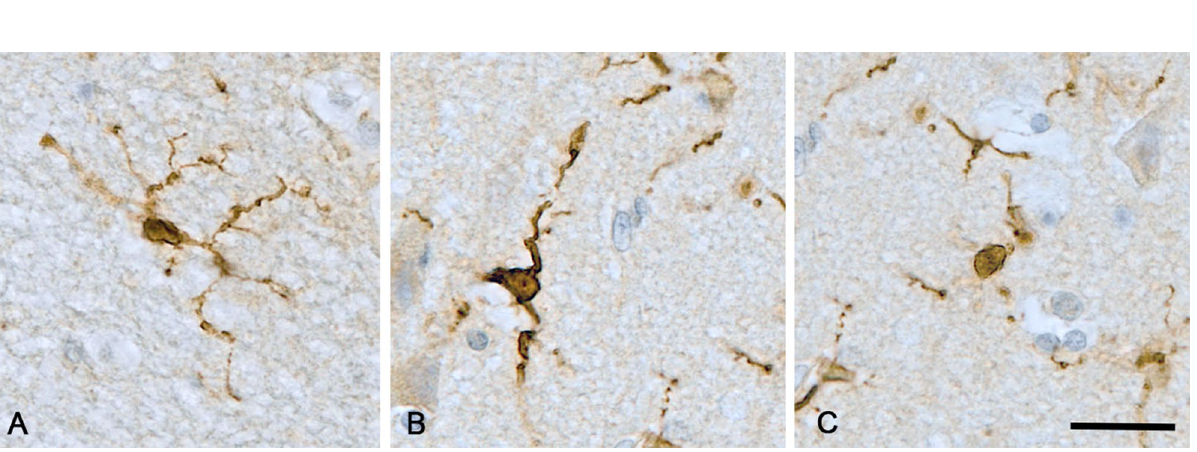
Figure 3. Illustration of the criteria used for the 2D morphological assessment of Iba1-positive microglia showing ( A ) ramified; ( B ) reactive and ( C ) amoeboid microglial cell. Haematoxylin counterstaining. Brain area: inferior parietal lobule. Scale bar = 20